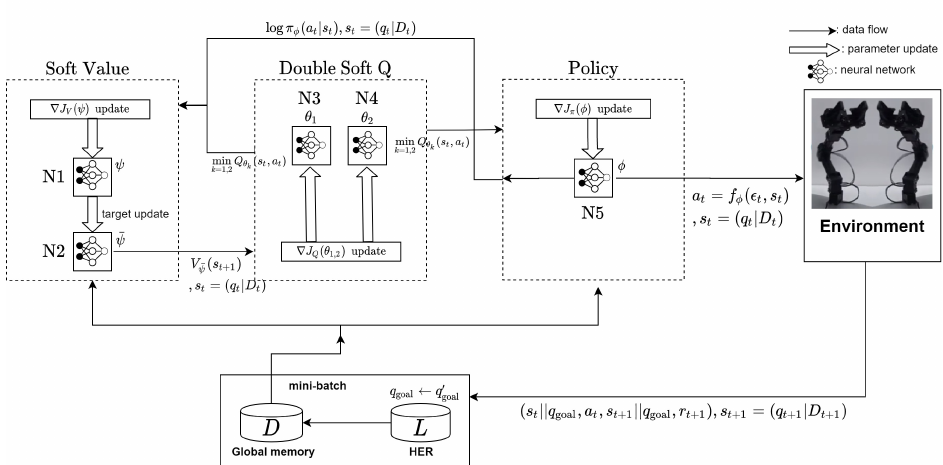
Figure 2. Architecture of the proposed SAC-based with the HER path planning